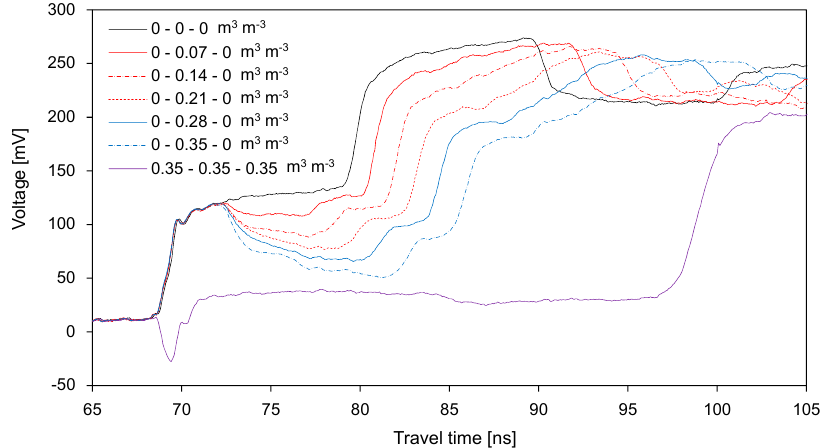
Figure 11. Variance of the signals with the SWC in the dry-wet-dry treatment.